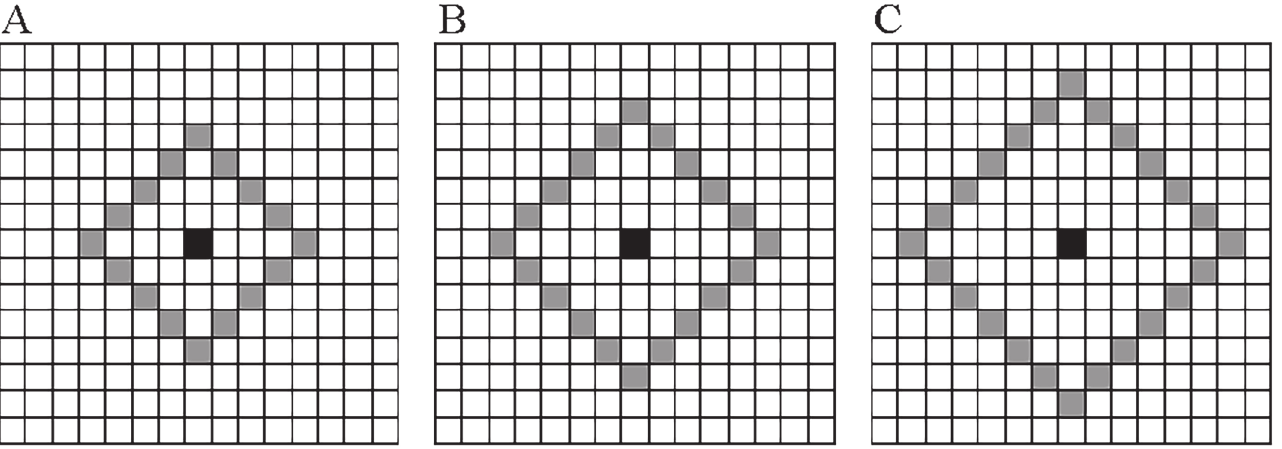
Fig 2. Spatial relationship between a patch and its neighbors for different radius R . (A) R = 4; (B) R = 5; (C) R = 6. The center pixel of current patch is indicated by the “ black ” square, and center pixels of neighbors are denoted by the “ grey ”